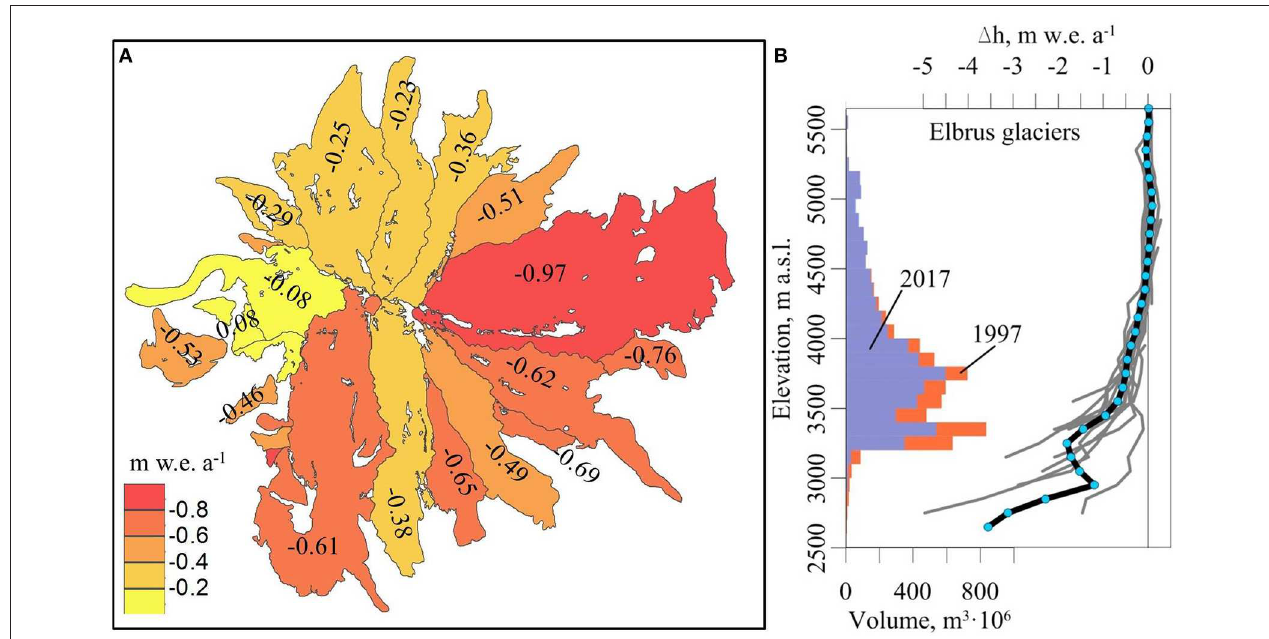
FIGURE 6 | (A) Glacier wide average mass balances. (B) Elbrus glacier volume distribution with elevation in 1997 and 2017, together with average annual elevation change values for 100m elevation bins (black curve). Elevation change values of 16 individual glaciers (gray lines) are also shown. Similar plots for individual glaciers are provided in Figure S1